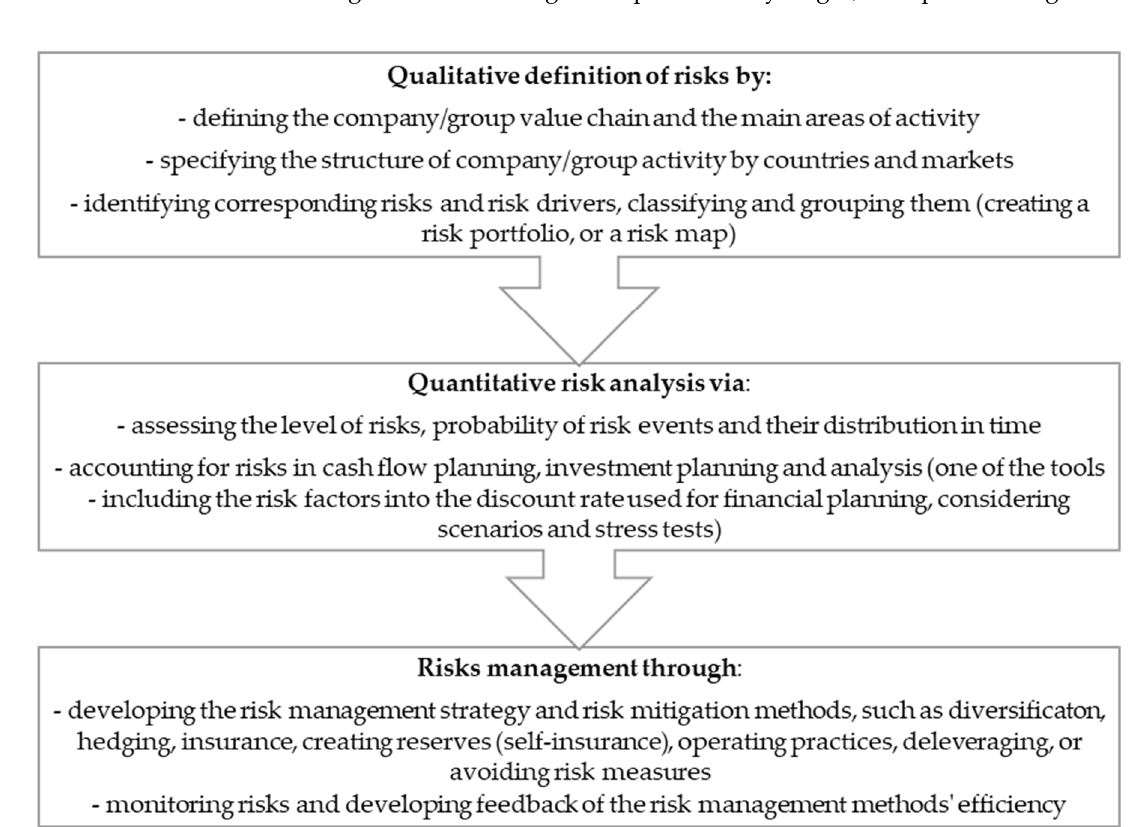
Figure 1. Stages of risk management process. Developed by the authors based on different sources.